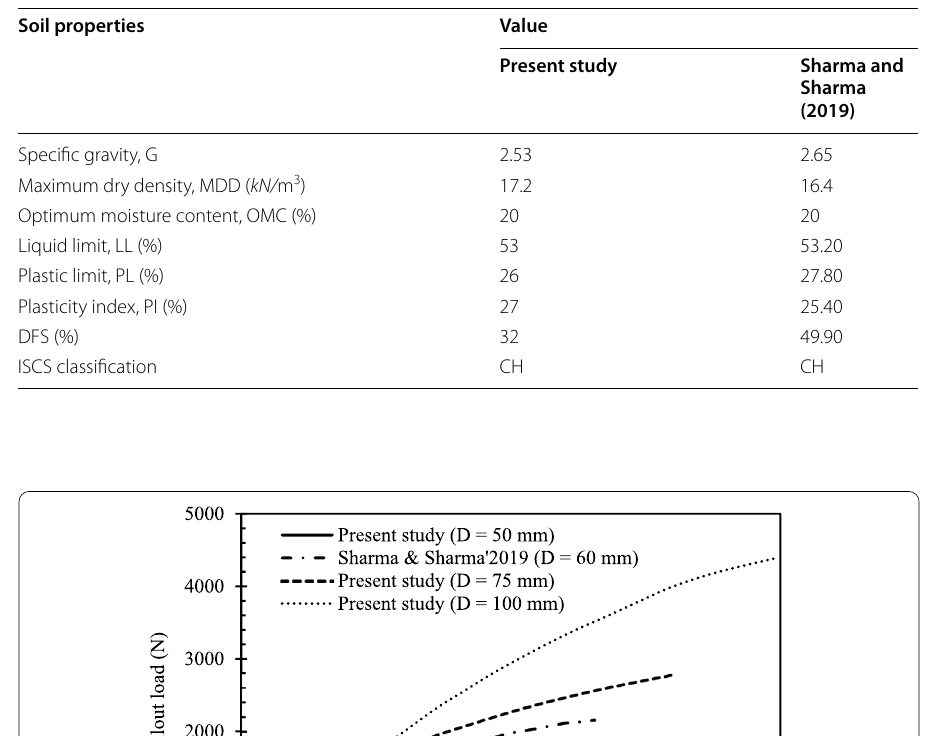
Table 13 Comparison of geotechnical properties of the clayey soil used in the present study and Sharma and Sharma